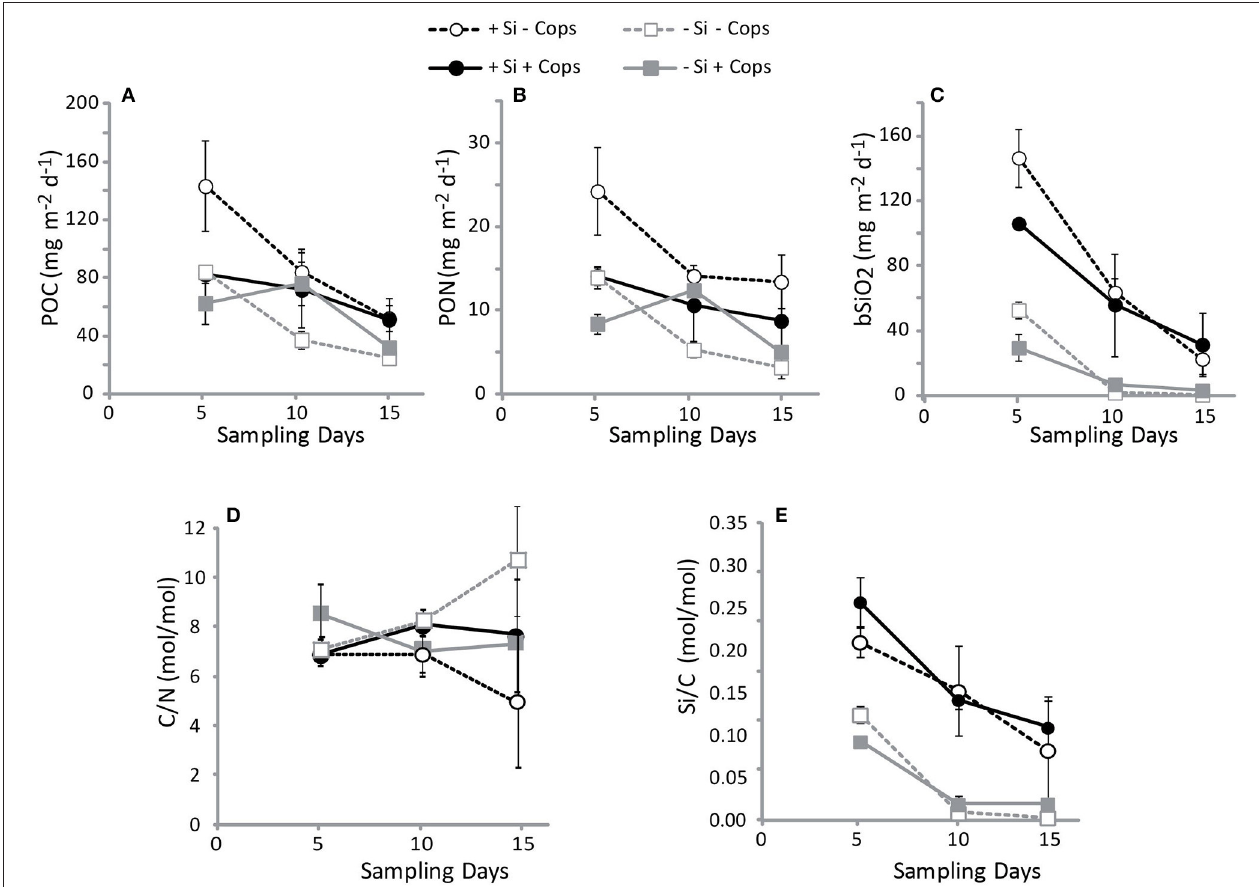
FIGURE 8 | Flux of material into the sediment traps and its elemental composition averaged for each mesocosm treatment. (A) POC, (B) PON, (C) bSiO 2 , (D) the C/N of the sinking flux, and (E) the Si/C of the sinking